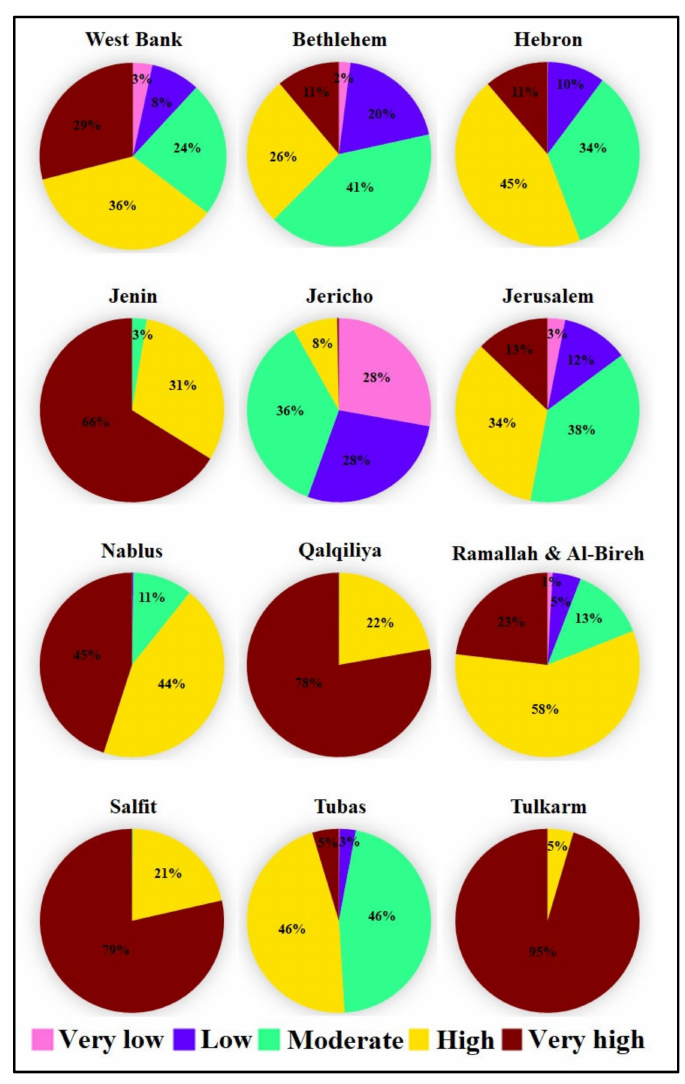
Figure 7. Areas (%) of the five ARWHS categories in the West Bank